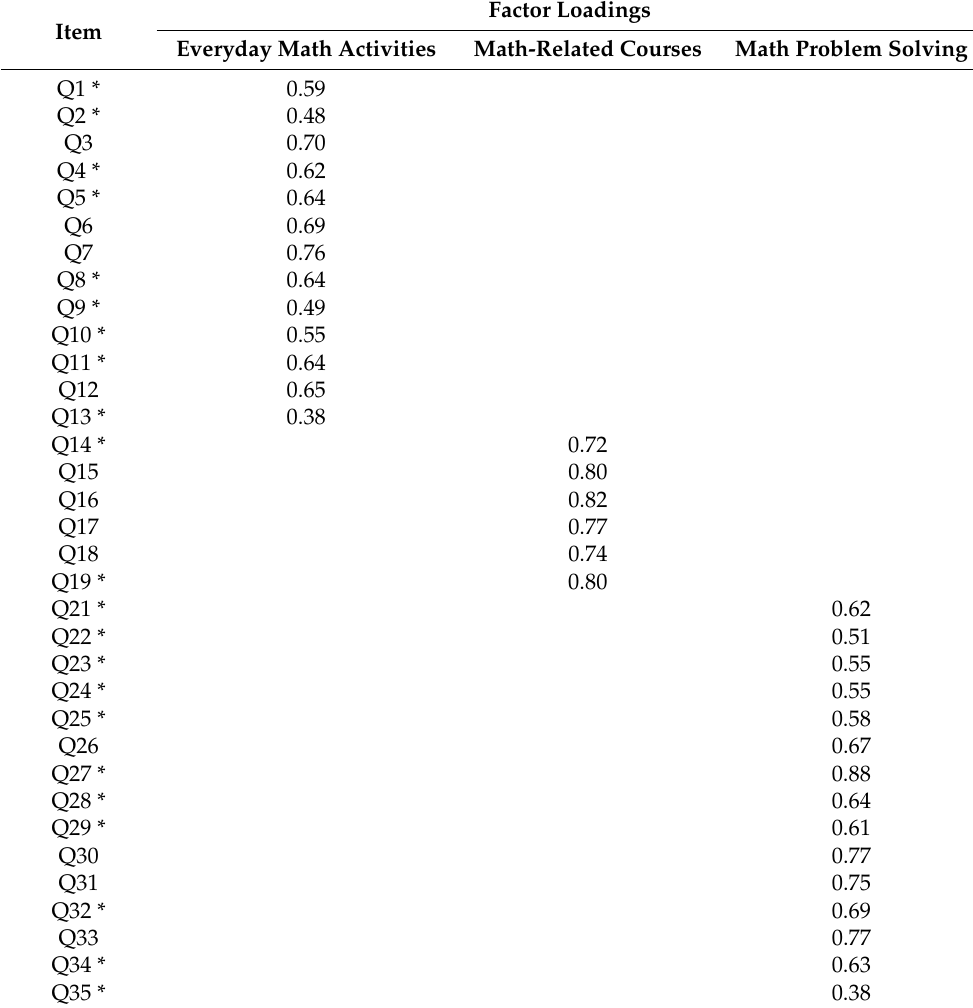
Table 1. Loading factors resulting from the exploratory factor